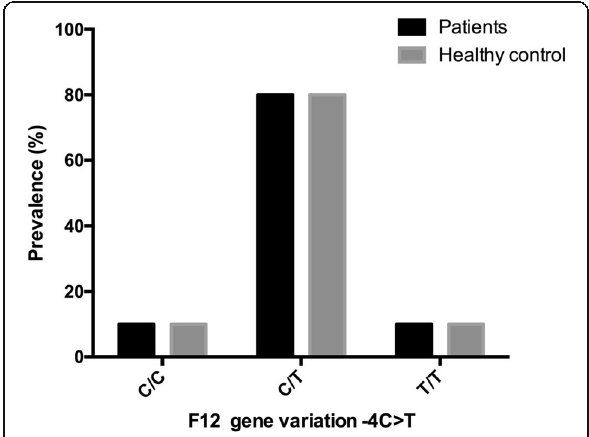
Fig. 1 Prevalences of F12 C46T variant in patients with venous thromboembolism and healthy control. The three genotypes C/C, C/ T and TT have similar prevalences between patients with thrombotic complications and normal healthy control (C/C 56.4% vs 57.2%; C/T 41.5% vs 40.4%; T/T 2.1% vs 2.4%). The genotypes C/C and C/T